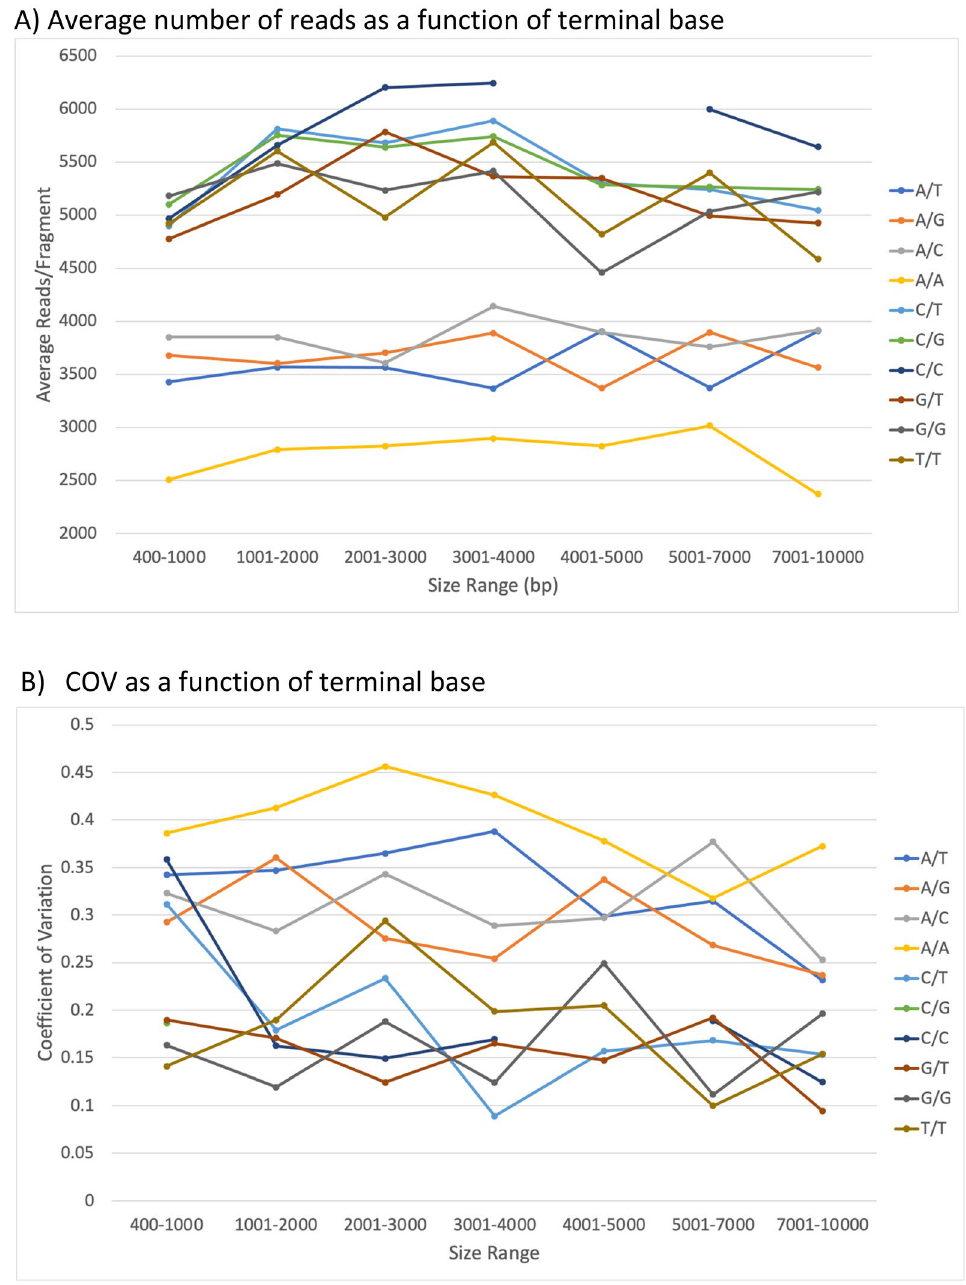
Figure 8. Read frequency as a function of length and 3’ terminal bases with Oxford Nanopore ligation-based library preparation. The average read count ( A ) and coefficient of variation ( B ) were calculated for all XmnI E. coli fragments from 400 to 10,000 bp. Length bins were selected to provide enough examples in each bin for all terminal base combinations. All points included > 5 fragments except for the 4001–5000 bp bin with CC termini which was omitted from the plots. All fragments with the same pair of 3’ ends were combined for